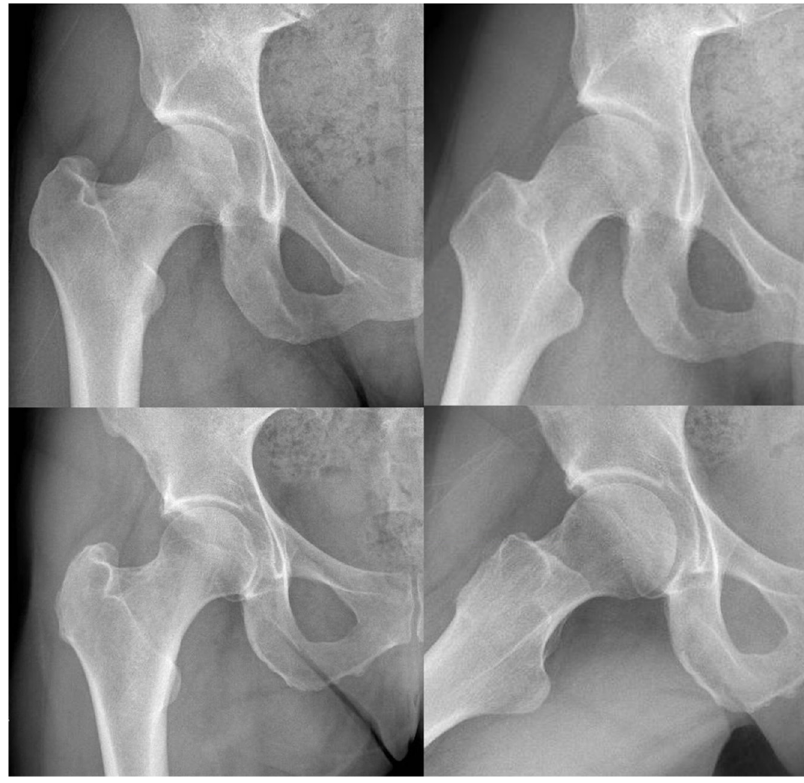
Figure 1. Radiographic comparations of CAM-type (first) and pincer-type (second)